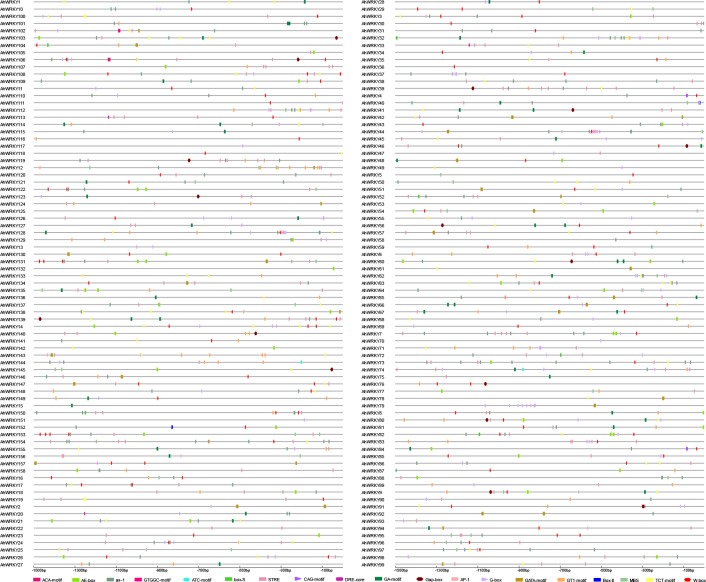
Predicted stress-related cis-elements in the AhWRKY promoters.The upstream length to the translation start site can be inferred according to the scale at the bottom. Different cis-elements were represented by different shapes and colors.